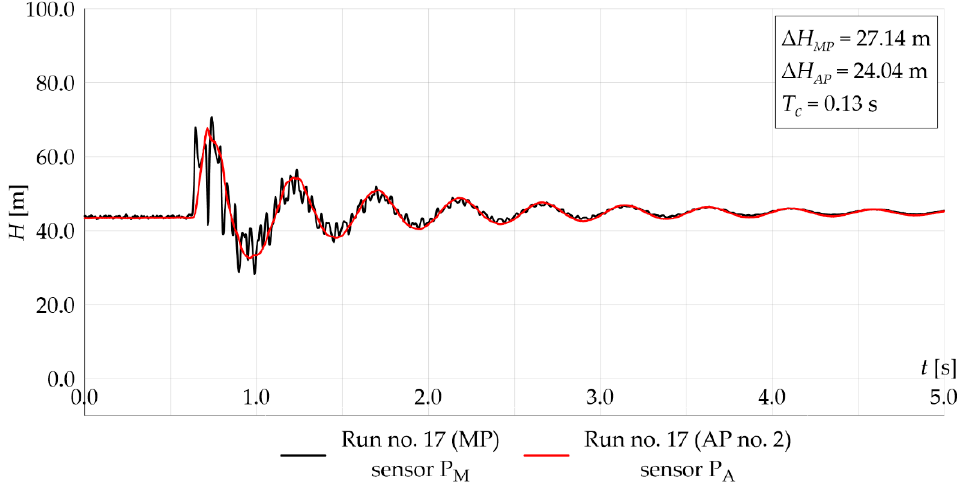
Figure 11. Pressure oscillations observed during run no. 17. The unsteady flow oscillations in MP and AP, observed during the water hammer run induced by slow valve closure, are presented in Figure 12.